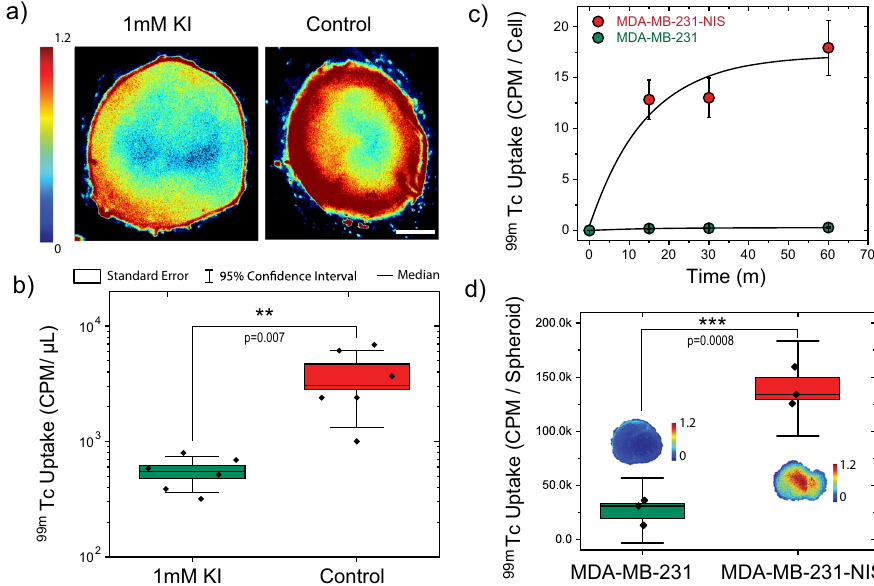
Fig. 6 Functional characterization of NIS activity in tumor organoids derived from papillary thyroid carcinoma patients. a oPEM imaging of pertechnetate ( 99m TcO − 4 ) uptake by tumor organoids with (left) or without (right) competitive inhibition by 1 mM potassium iodide (KI). Scale bar: 200 µ m. b A nearly 10-fold difference in 99m TcO − 4 uptake is observed between the two experimental conditions ( n = 6 independent tumor organoids). Data are shown as mean ± S.E.M. (box), median (horizontal line), and 95% con fi dence interval (CI; whiskers). c 99m TcO − 4 uptake kinetics of NIS- expressing and wild-type MDA-MB-231 cells. Error bars correspond to the standard error from n = 3 independent measurements. d Gamma counting and oPEM images of 99m TcO − 4 uptake by 3D multicellular spheroids (10,000 cells/spheroid) made from NIS-expressing and wild-type MDA-MB-231 cells ( n = 3 independent spheroids). Data are shown as mean ± S.E.M. (box), median (horizontal line), and 95% CI (whiskers). Statistical signi fi cance was assessed using a two-tailed unpaired t test ( b , d ). CPM: counts per minute. The color bar shows radioactivity